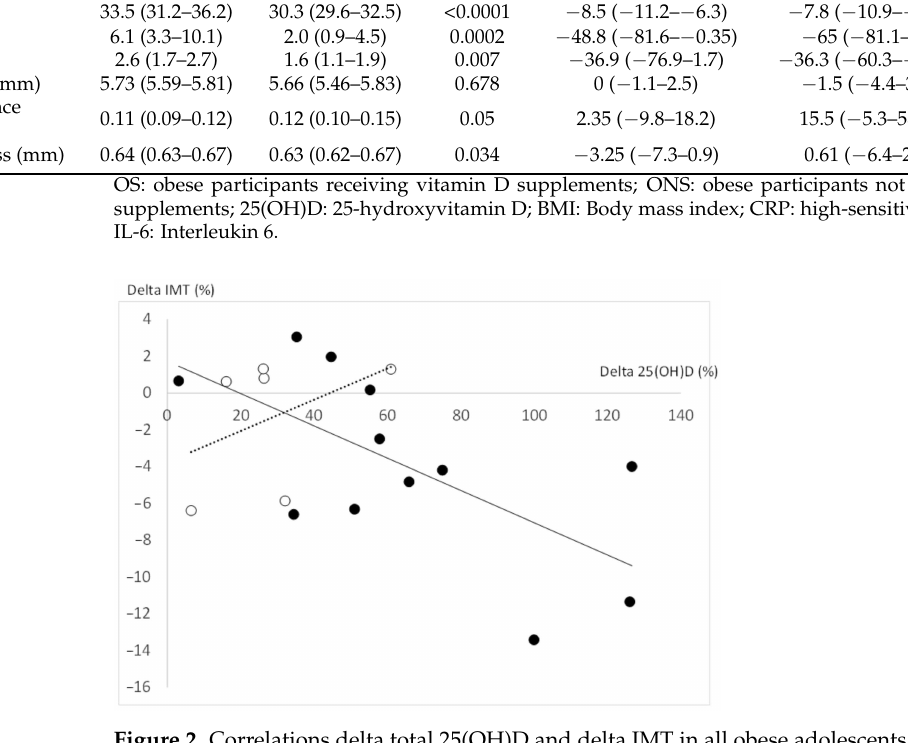
Figure 2. Correlations delta total 25(OH)D and delta IMT in all obese adolescents: obese participants with VD insufficiency at baseline (black circle) and obese participants without VD insufficiency at baseline (white circle). 25(OH)D: 25-hydroxyvitamin D; IMT: Intima-media thickness; VD: Vitamin